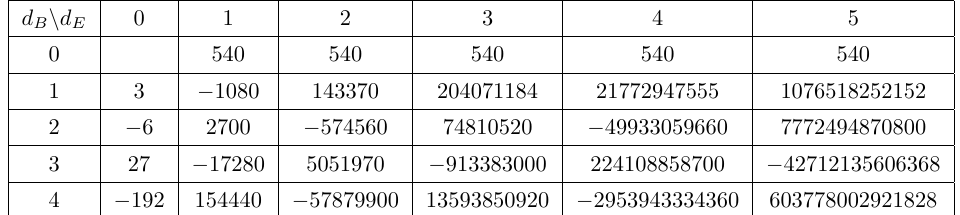
for the genus ( g ) = (0 , 0) L , g R ( d B ,d E )